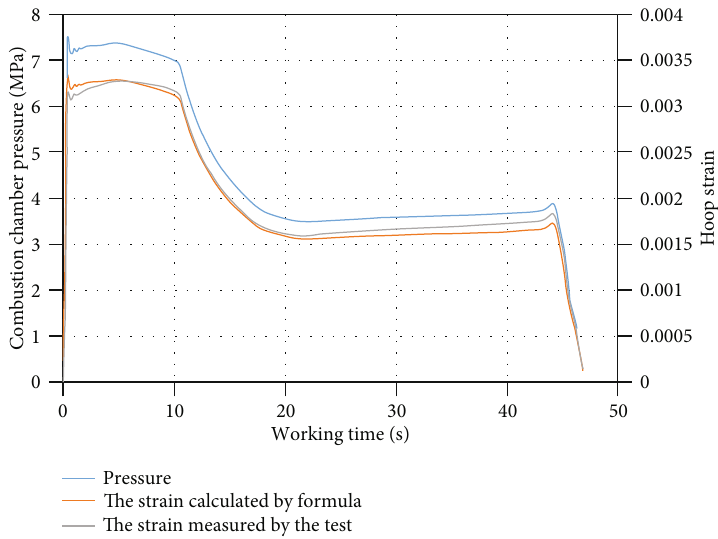
Figure 6: The change tendency of the hoop strain of the case during the motor working